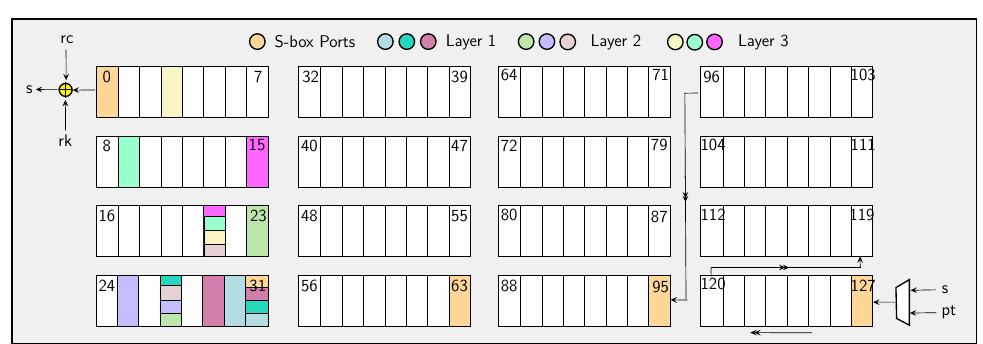
Figure 6: 128-cycle, bit-serial GIFT ∗ round function implementation using nine